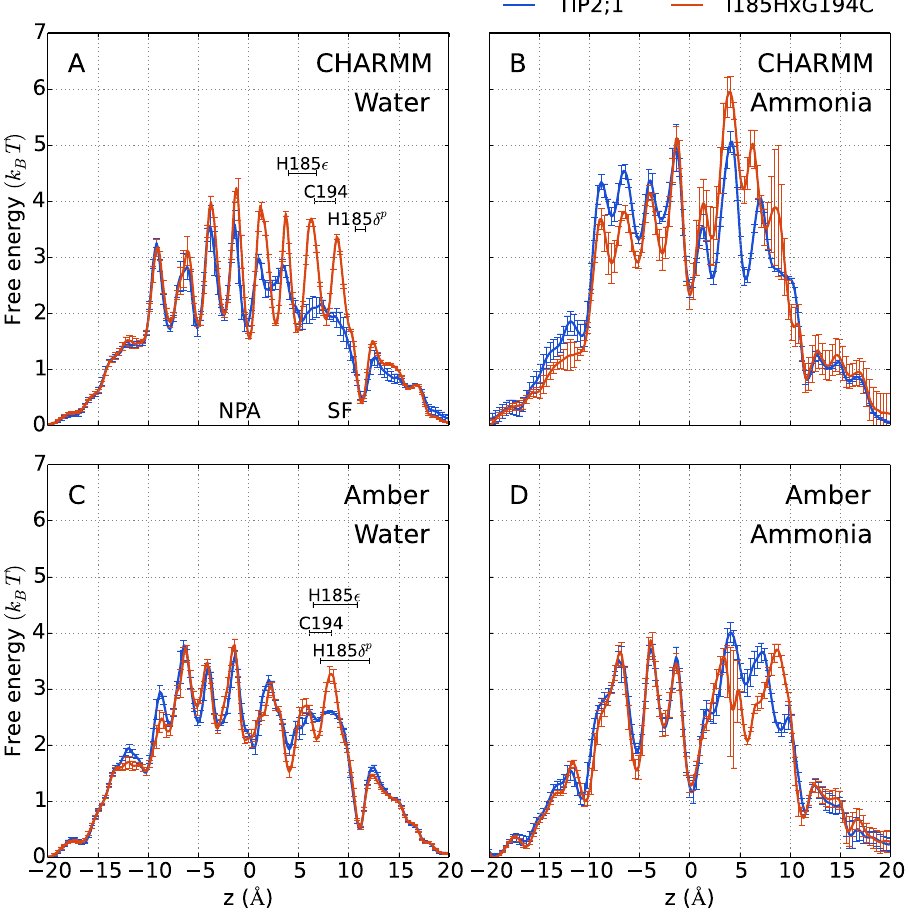
Figure 5. Free energies along z for ammonia and water. The error bars indicate estimated uncertainties of the average taken over the monomers. The larger error bars at z ≈ 4 Å in the profile for ammonia and Amber I185H × G194C are due to the rare sampling of a side pocket in one of the monomers. For the ammonia profile of CHARMM I185H × G194C, the uncertainty of the barrier height at z ≈ 9 Å is large due to H131 flipping away from the SF region in one of the monomers, decreasing the free energy estimate. The location of mutated residues are indicated by the average z positions ( ± the standard deviation) of water molecules when hydrogen bonding to these pore sites (as in Fig.